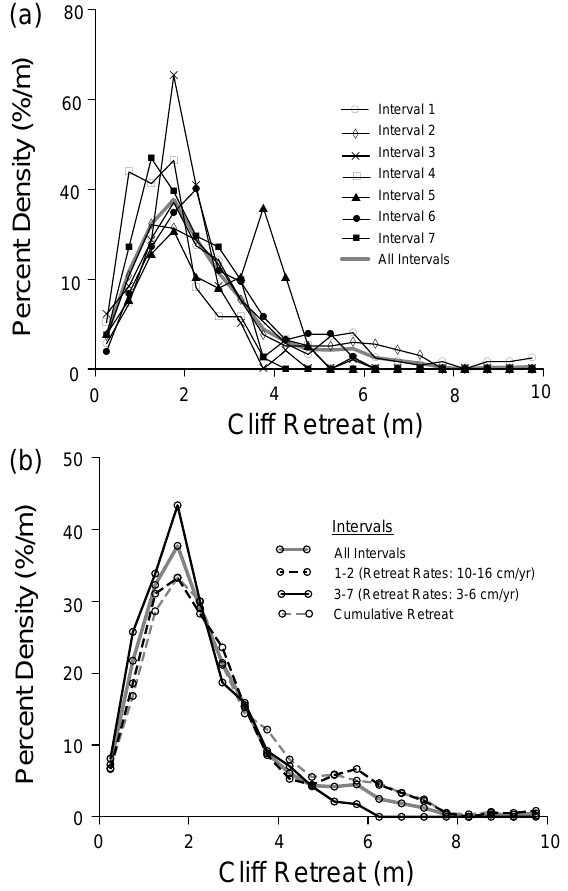
Fig. 9. Probability density functions of transect (a) cliff retreat occurring during each time interval, and (b) combined time periods with relatively high (Intervals 1 and 2) and low retreat rates (Intervals 3 through 7). The probability density functions are based on 0.5m intervals and plotted along the x-axis using the mid- interval location.